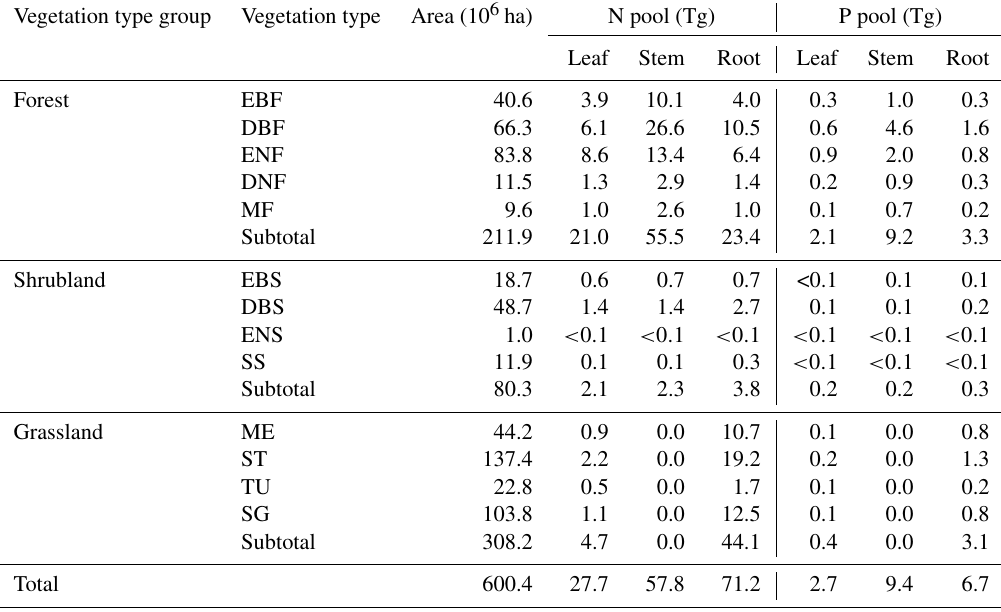
Table 2. N and P stocks of plant organs (leaf, stem, and root) in forests, shrublands, and grasslands in China. Vegetation type